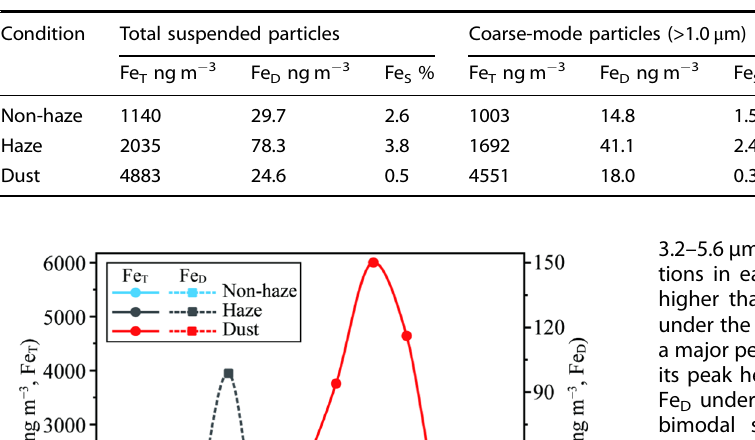
Table 1. Concentrations of total Fe (Fe T ), dissolved Fe (Fe D ), and Fe solubility (Fe S ) in total suspended, coarse-, and fi ne-mode particles, as well as the enrichment factor of Fe (EF Fe ) in coarse- and fi ne-mode particles under non-haze, haze, and dust conditions.